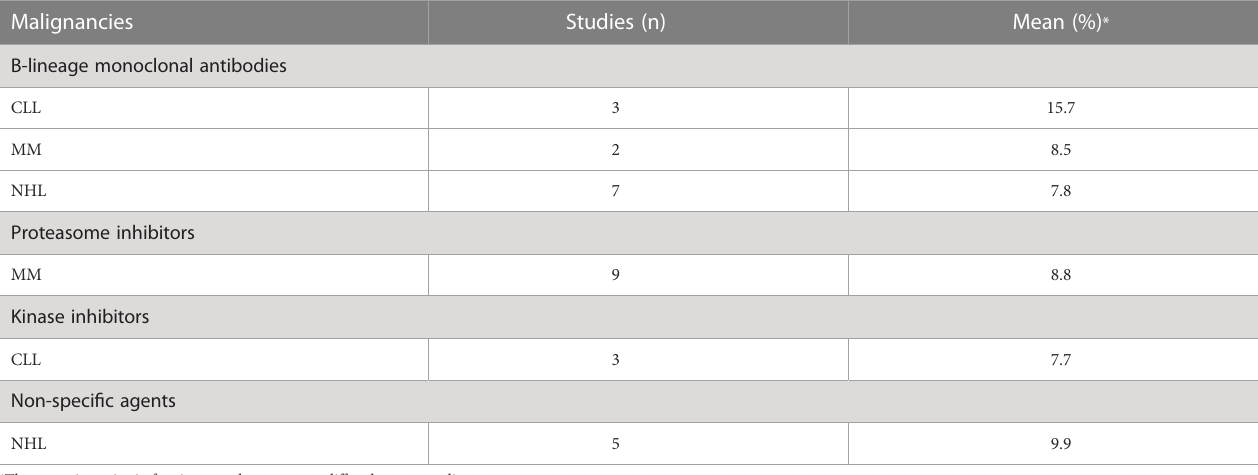
TABLE 6 Proportions of patients with CLL, MM, and NHL treated with different classes of drugs as monotherapy who had sinopulmonary bacterial infections. Malignancies Studies